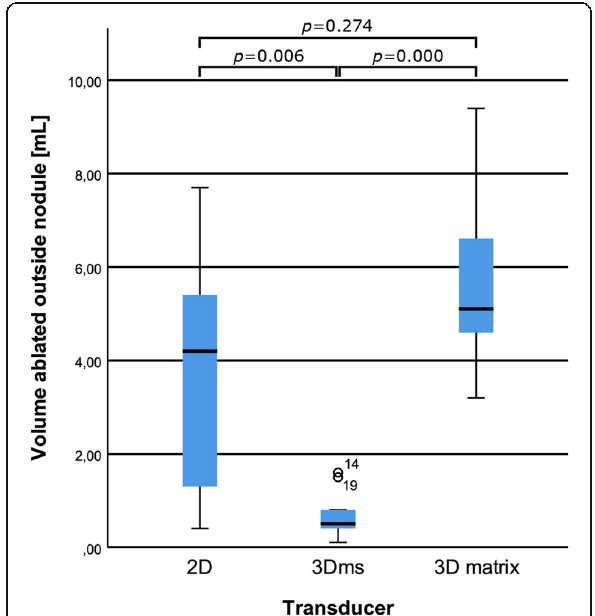
Fig. 7 Boxplot of the volume ablated outside the nodule per transducer with corresponding p values